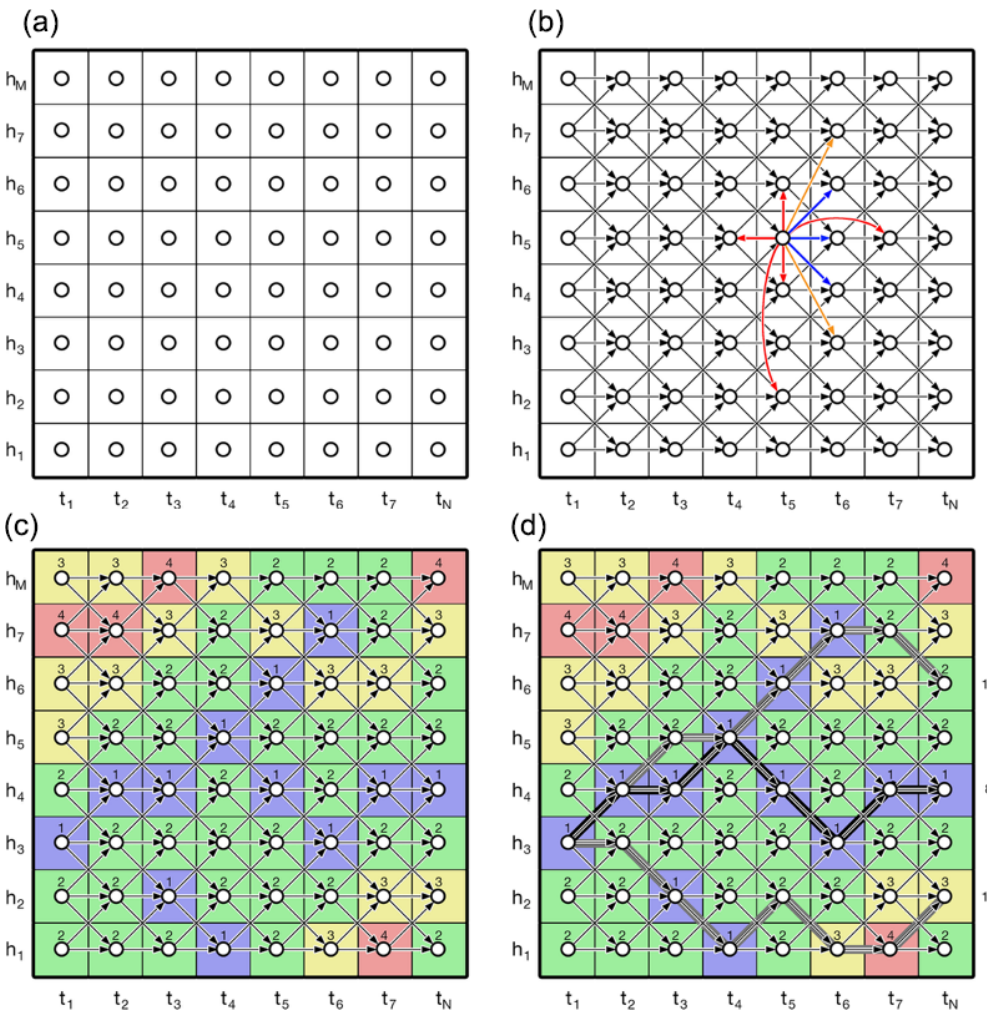
Figure 2. Overview of the translation of data into a mathematical graph and subsequent steps to determine MLH. (a) One-to-one translation of data points to graph vertices. (b) Grid of connections between vertices, for a single vertex allowed connections are shown in blue, examples of forbidden connections shown in orange and red. (c) Assignment of costs to the graph connections based on RCS vertical gradients. (d) Selection of correct path with Dijkstra’s algorithm, with three possible paths originating from the same point. Their total cost is displayed at the right. The middle path will be selected as the MLH development estimate as this is the path with the lowest possible